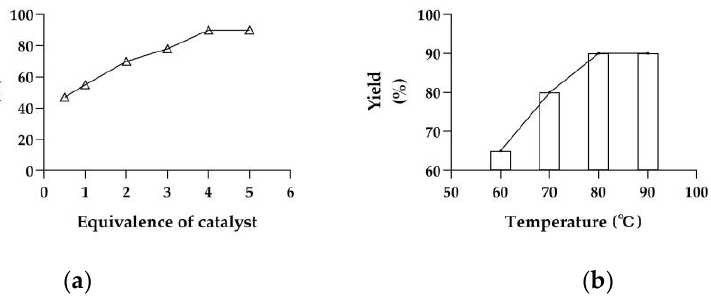
Figure 2. Optimization of the reaction conditions. ( a ) The effect of various equivalence of p -TsOH; ( b ) The effect of various temperature. The amount of p -TsOH was 0.5 mmol. General conditions: 1a (0.125 mmol), 2a (0.625 mmol), ACN (0.2 mL) at 80 °C or indicated temperature for 22 h.